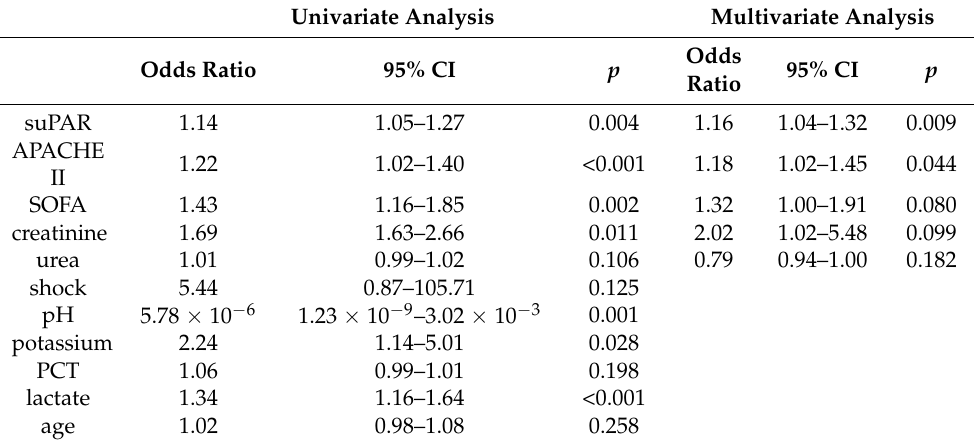
Table 3. Results of a multivariate logistic regression analysis model predicting the need for kidney replacement therapy in patients with